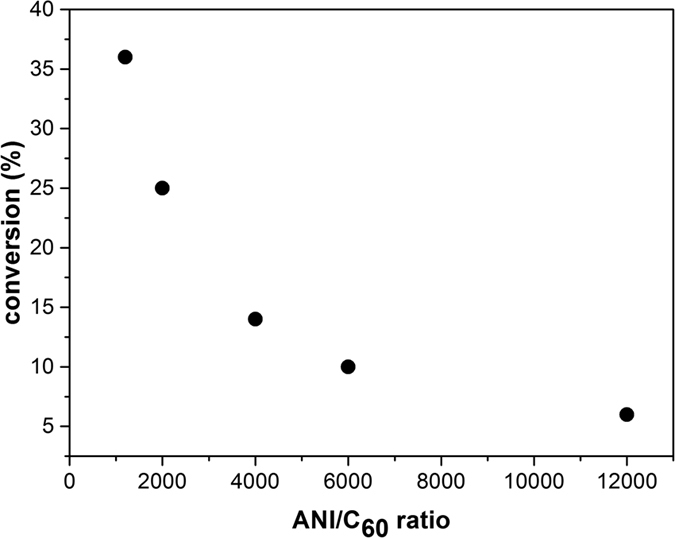
The conversion versus ANI/C60 ratio.